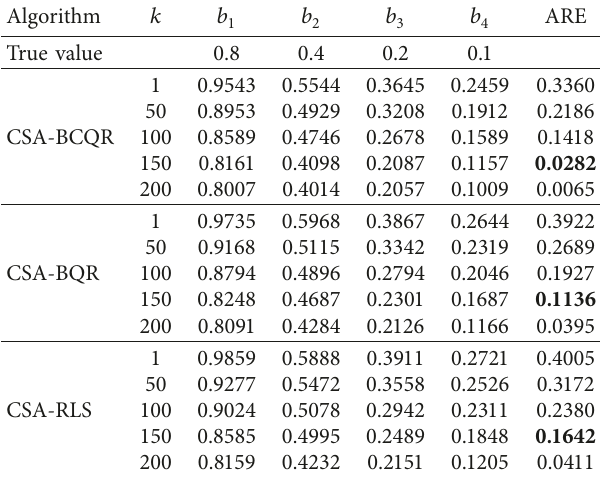
Figure 5: A water tank model. Table 2: Comparison among CSA-BCQR, CSA-BQR, and CSA- RLS in the water tank.